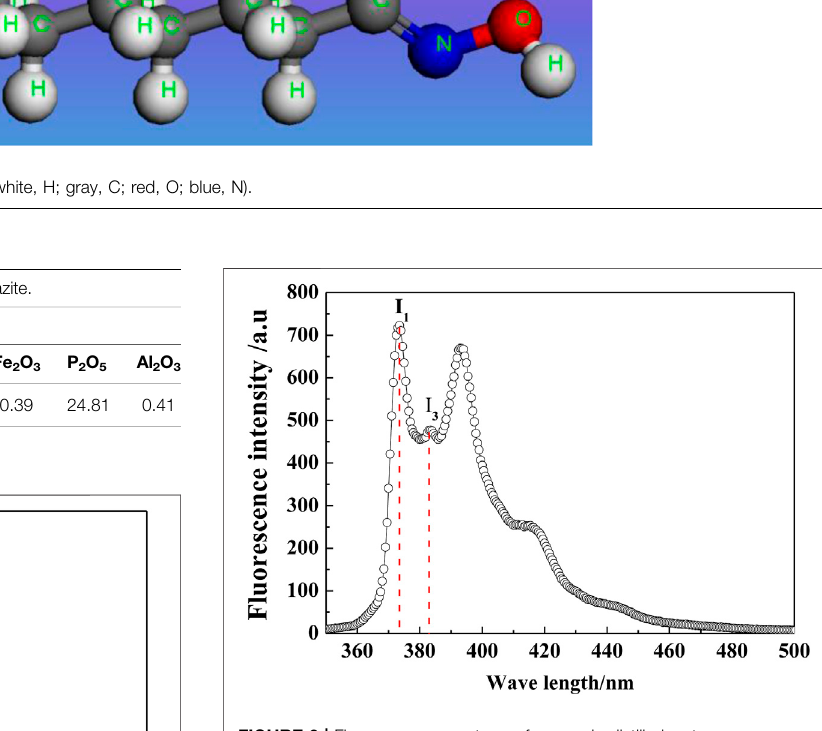
FIGURE 3 | Fluorescence spectrum of pyrene in distilled